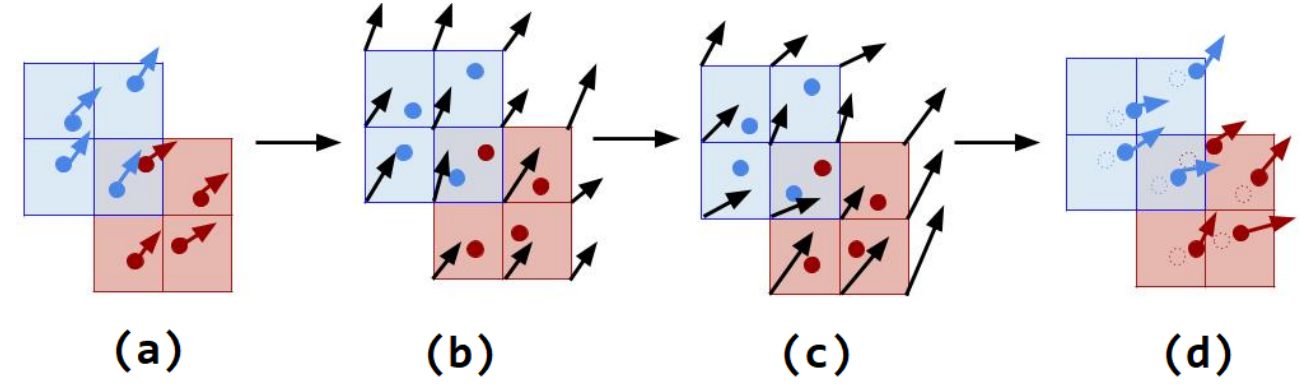
Figure 3. The Material Point Method (MPM) algorithm with two grid multi-species. 1. ( a )->( b ) Transfer to grids: the mass and momentum of each species are transferred to its corresponding grid. 2. ( b )->( c ) Update the grids’ momentum: the coupled water and soil grid velocities are updated. 3. ( c )->( d ) Update the particles: all particle states, including the momentum, velocity, and cohesion based on saturation, are